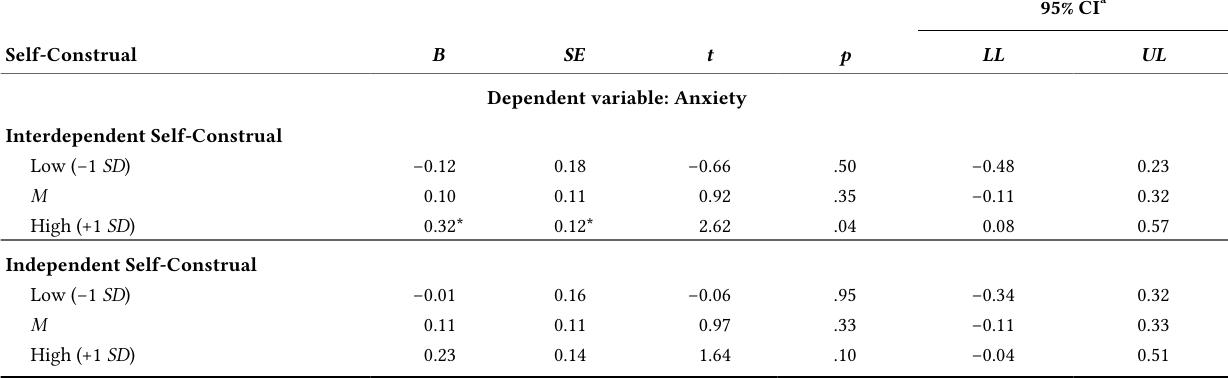
Graphical Representation of the Statistically Significant Moderation Effects (B-Coefficients, SE in Parenthesis)